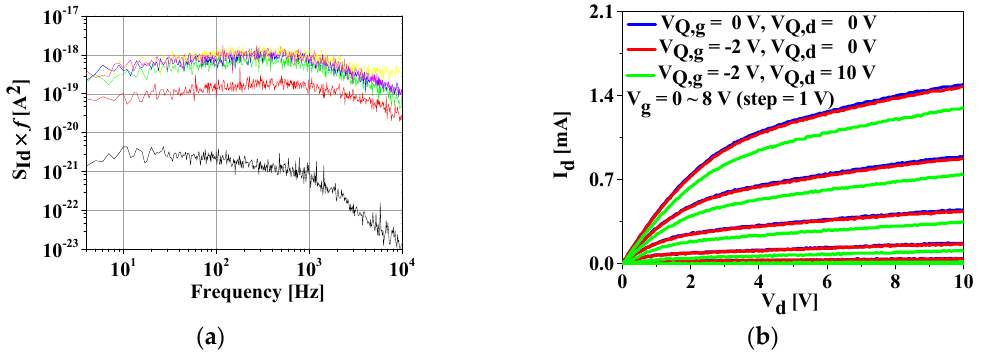
Figure 4. ( a ) Product S Id × frequency as a function of frequency in the fabricated GaN MISFET varied V d = 0.1 ~ 5 V. ( b ) Pulsed I d -V d curves for the device sweeping V d = 0 ~ 10 V.